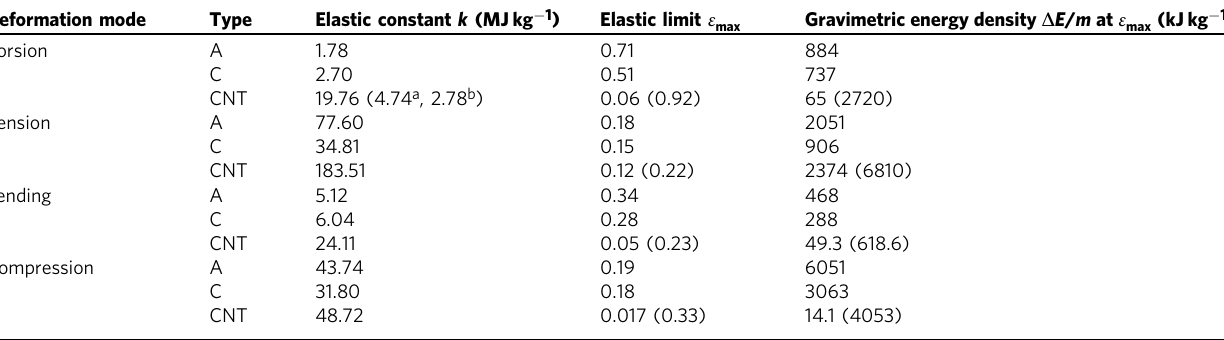
Table 1 Mechanical properties of carbon nanothreads and CNT(10,10) as derived from MD simulations. Deformation